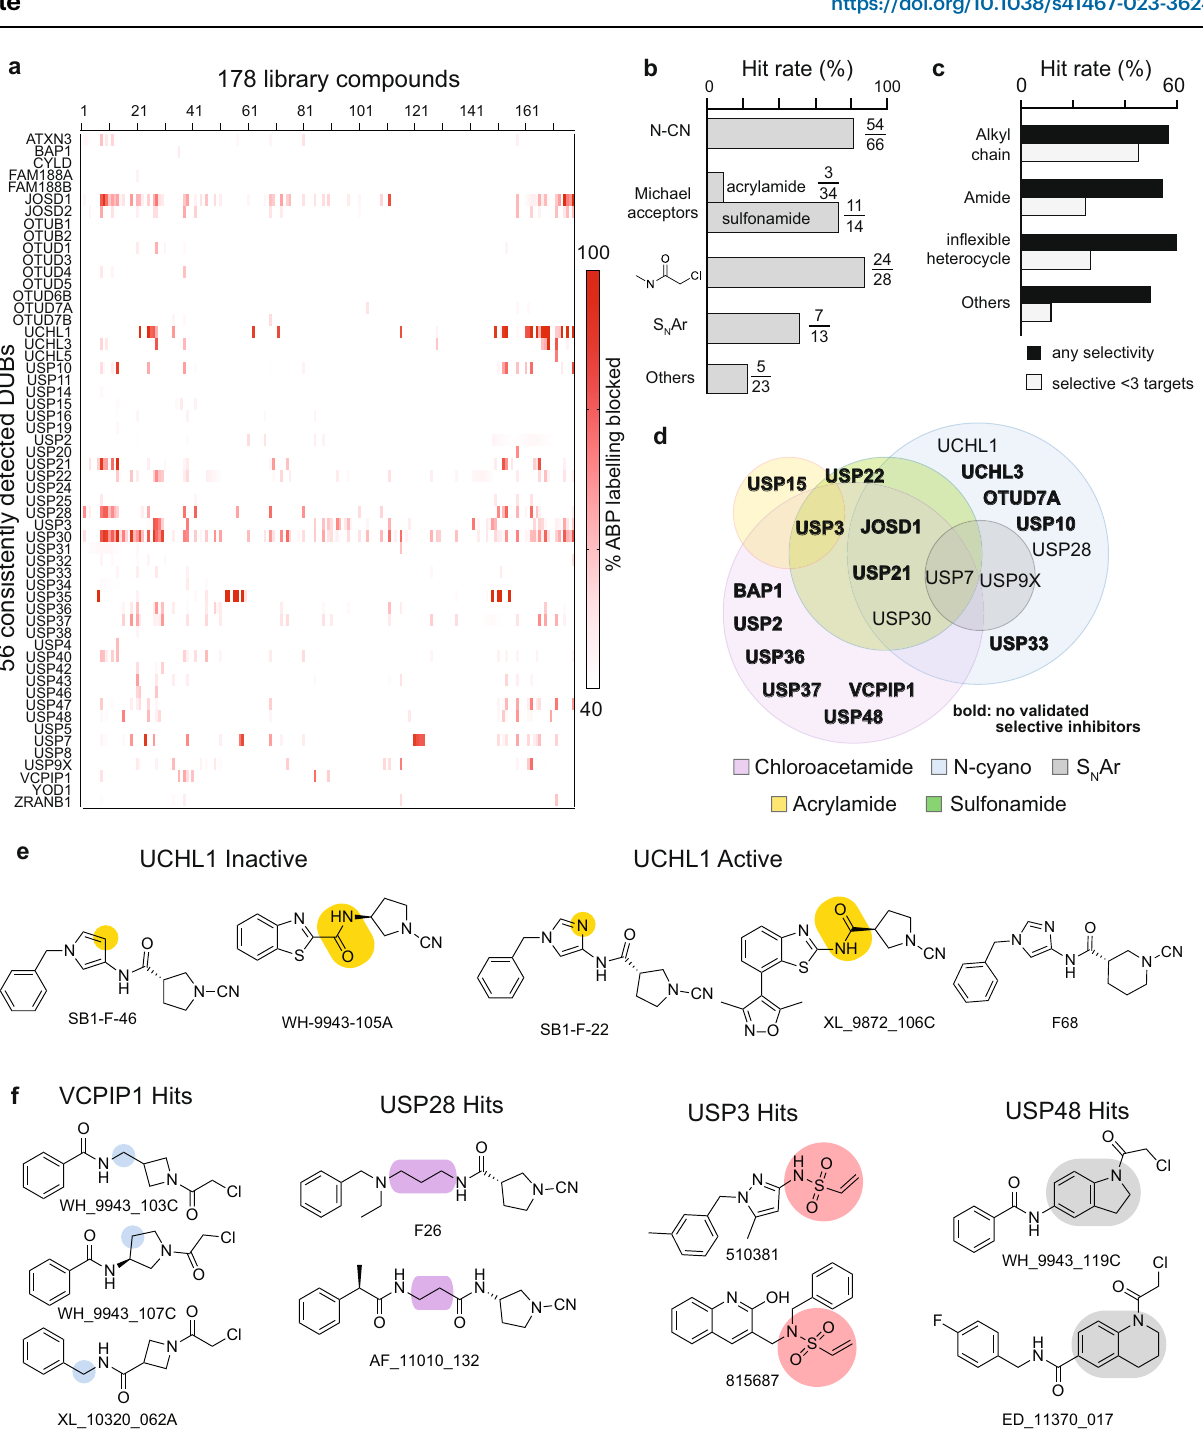
are hitherto untargeted. e , f Selected representative examples for multiple che- mically similar hits for the same DUB from the screen. In the case of UCHL1, stringent requirements surrounding hydrogen bond acceptor position and amide orientation on the linker are highlighted in yellow. For VCPIP1, compounds were structurally similar except for the methylene group which moved along the backbone of the molecule (in blue). Moieties common across hits are highlighted for USP28 (in purple), USP3 (in red), and USP48 (in